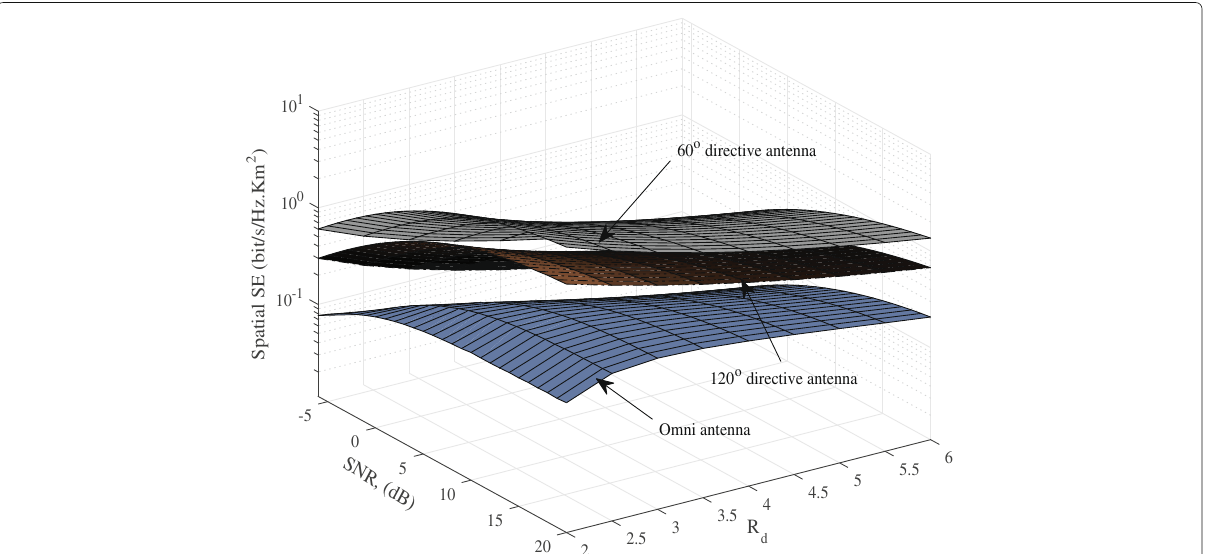
Fig. 11 Spatial spectral efficiency in (bit/s/Hz km 2 ) of multi-cell cellular network as a function of SNR and normalized reuse distance, R d for omni, 120 ◦ and 60 ◦ antenna configurations with m = 4 and α = 4. Spatial SE for omni antenna system, spatial SE for 120 ◦ sectorized antenna system, spatial SE for 60 ◦ sectorized antenna system